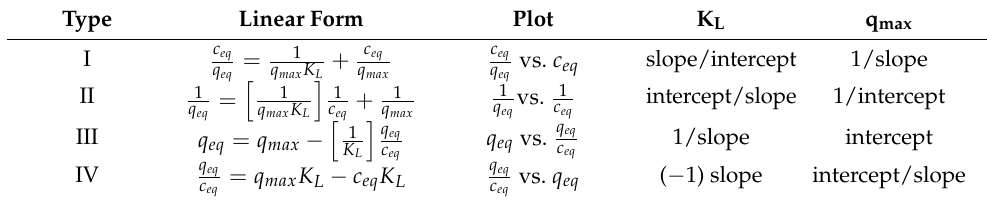
Table 3. Linear forms of the Langmuir isotherm (according to